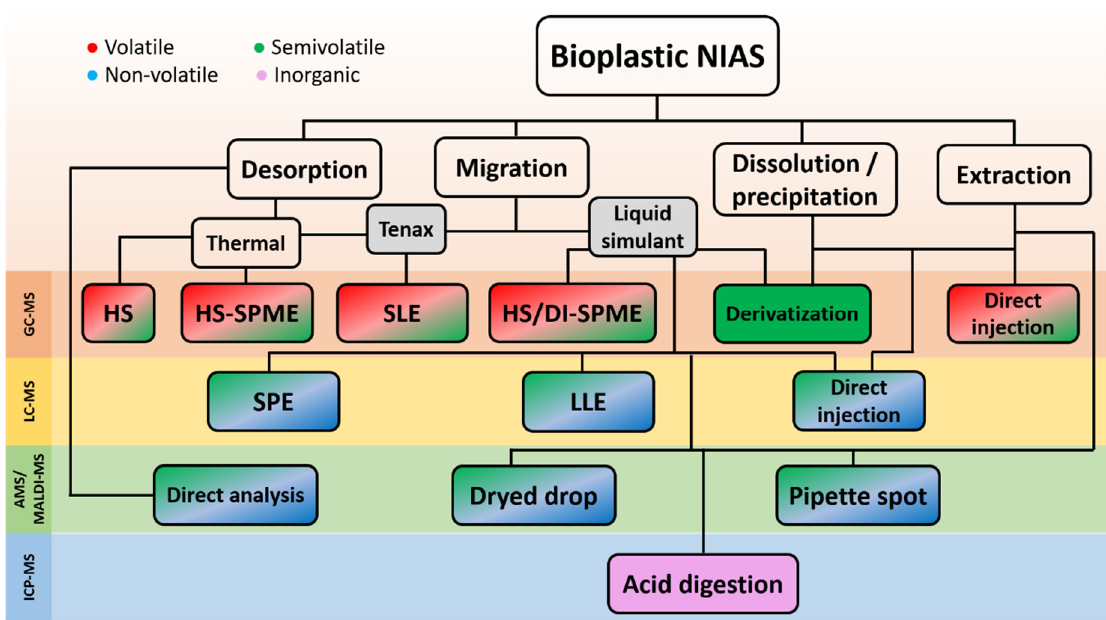
Figure 2. Schematic representation of MS-based analytical approaches for NIAS investigation.